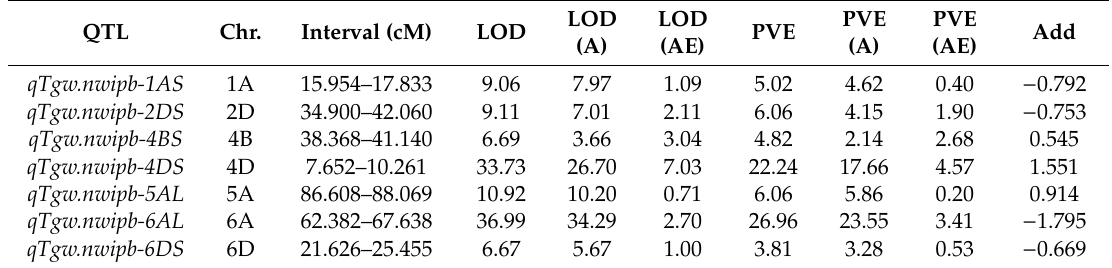
Table 4. QTL analysis for TGW from multienvironmental trials